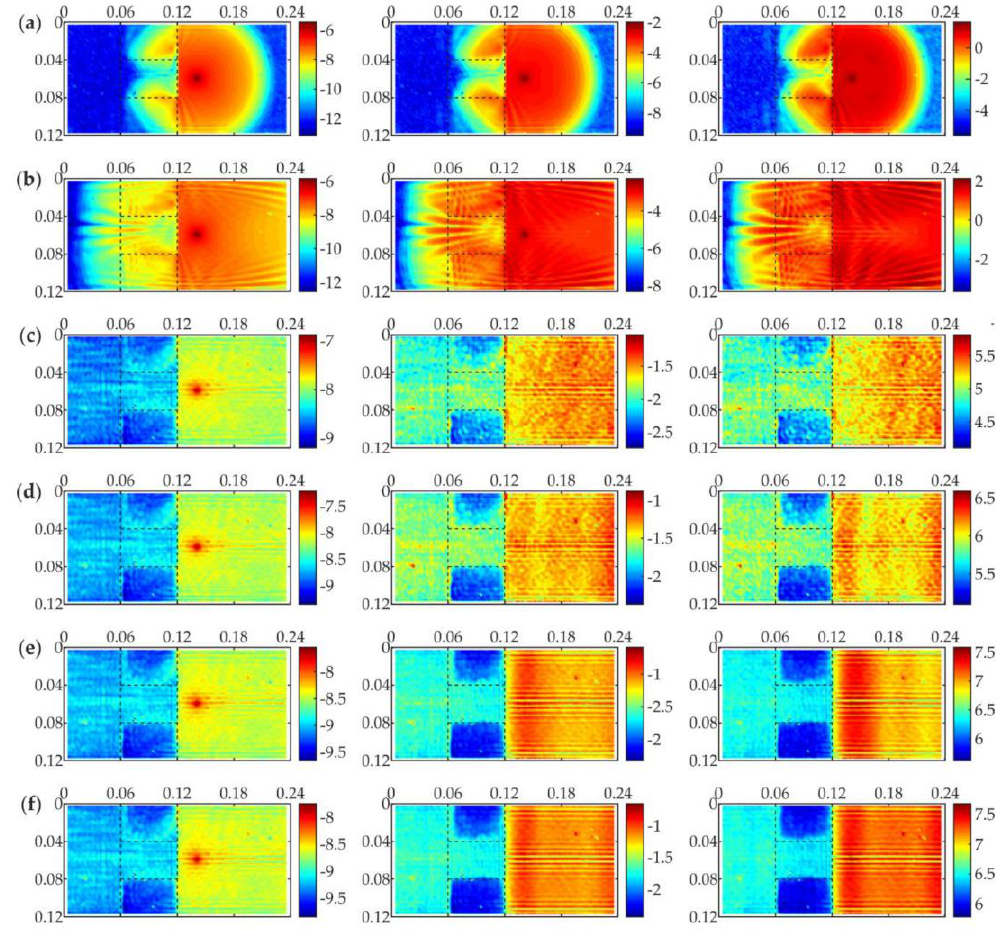
Figure 8. Weighted root mean square (WRMS) maps (values in (m/s)) for specimen #5 for different weighting factors w r = 1 (first column), w r = r (second column), w r = r 2 (third column) and varying time window: ( a ) T = 0.03 ms; ( b ) T = 0.05 ms; ( c ) T = 0.50 ms; ( d ) T = 1.00 ms; ( e ) T = 2.00 ms; and, ( f ) T = 3.00